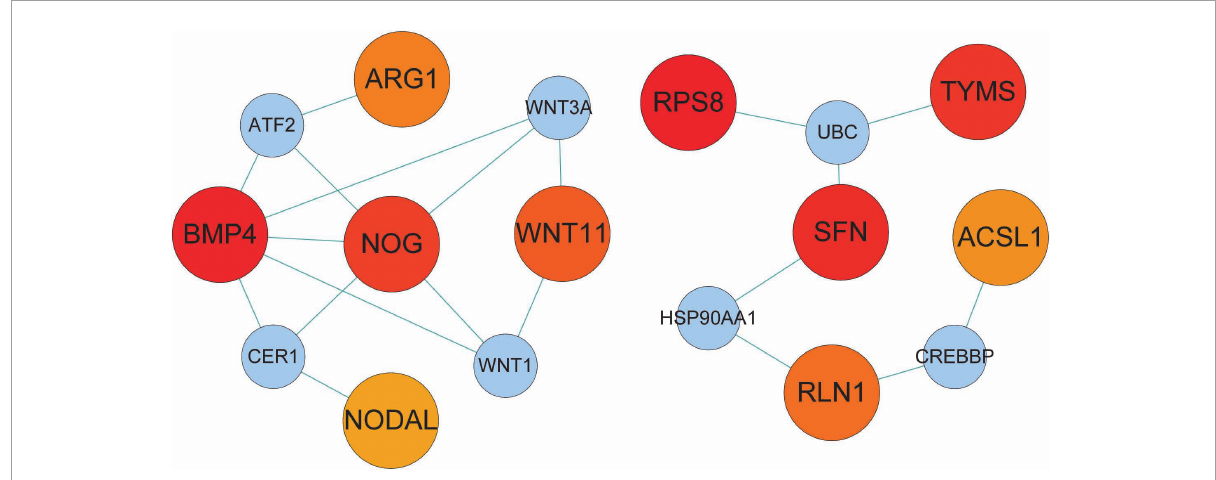
FIGURE5 Hub protein network of shared DEGs in COVID-19 and AF. The connecting lines represent the presence of interactions between two nodes. The nodes in the network are divided into two sizes, with larger nodes representing the proteins encoded by DEGs and smaller nodes representing other proteins to distinguish them from DEGs. The color shades of the nodes indicate the degree of connectivity. 10 hub proteins are shown based on the number of interactions.